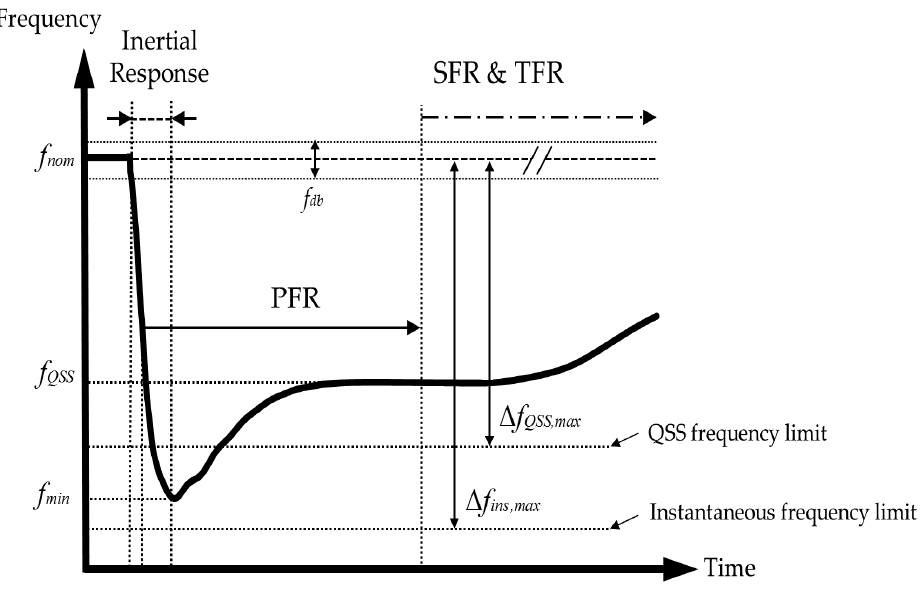
Figure 1. Frequency response of a stand-alone microgrid after a disturbance.